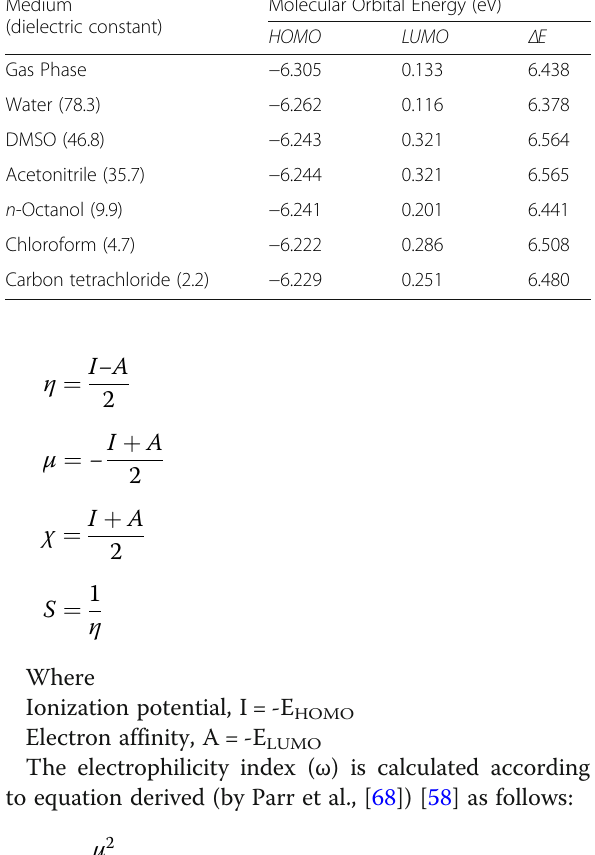
Table 5 Molecular Orbital Energy (eV) ( HOMO and LUMO) of betulinic acid in different solvents with SMD Medium (dielectric constant)